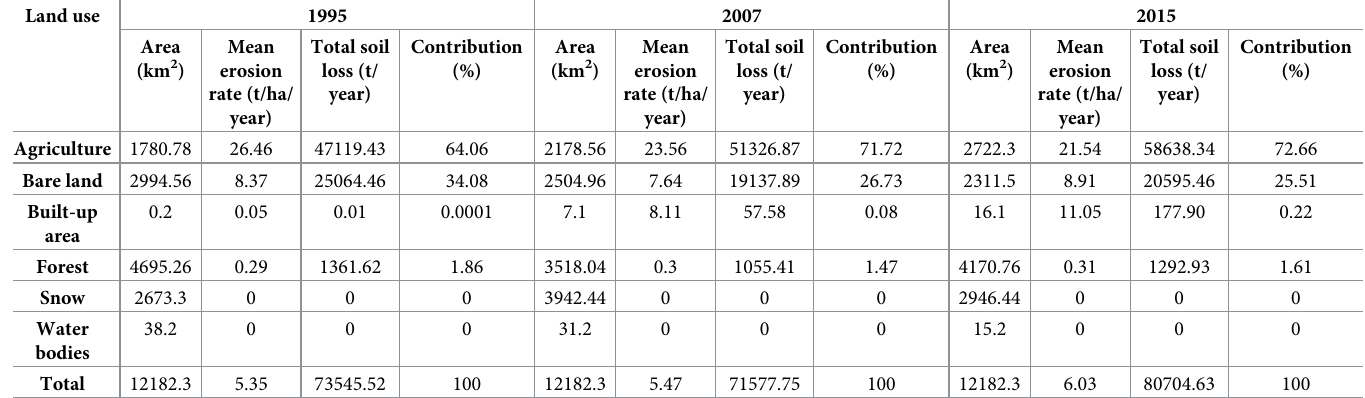
Table 8. Variation of soil loss with